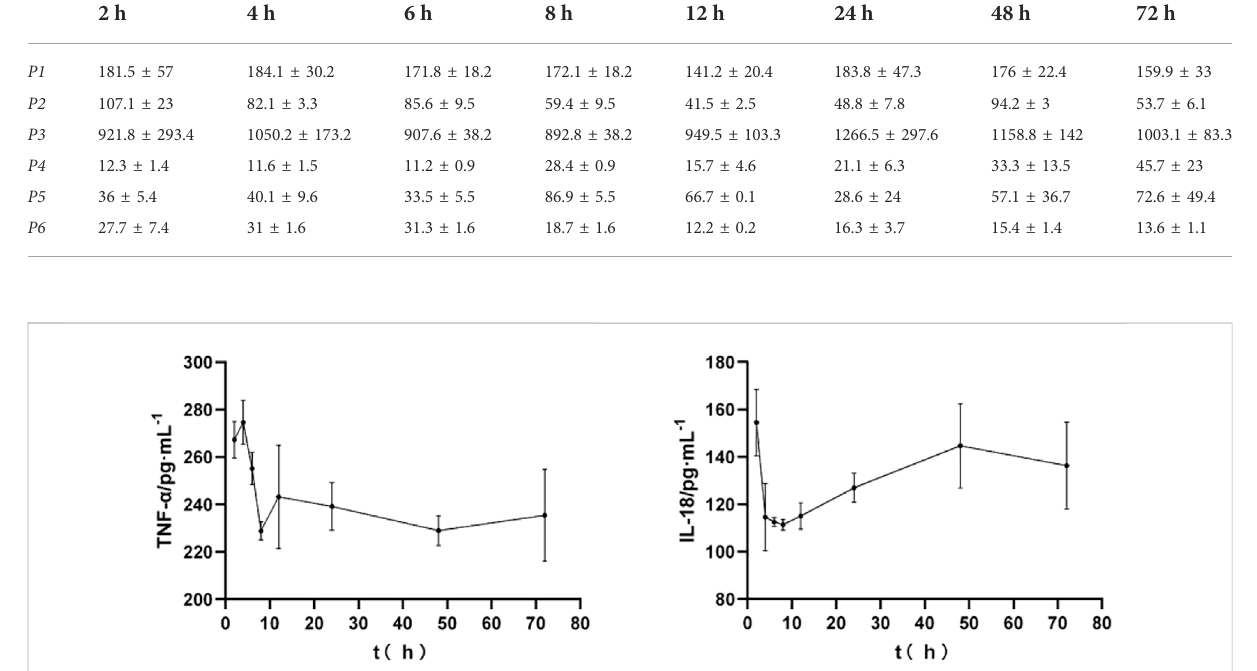
FIGURE 2 Effect of YYTNG on the in fl ammatory factors at different time points in MCAO rats ( (cid:1) x ±s, n = 6)